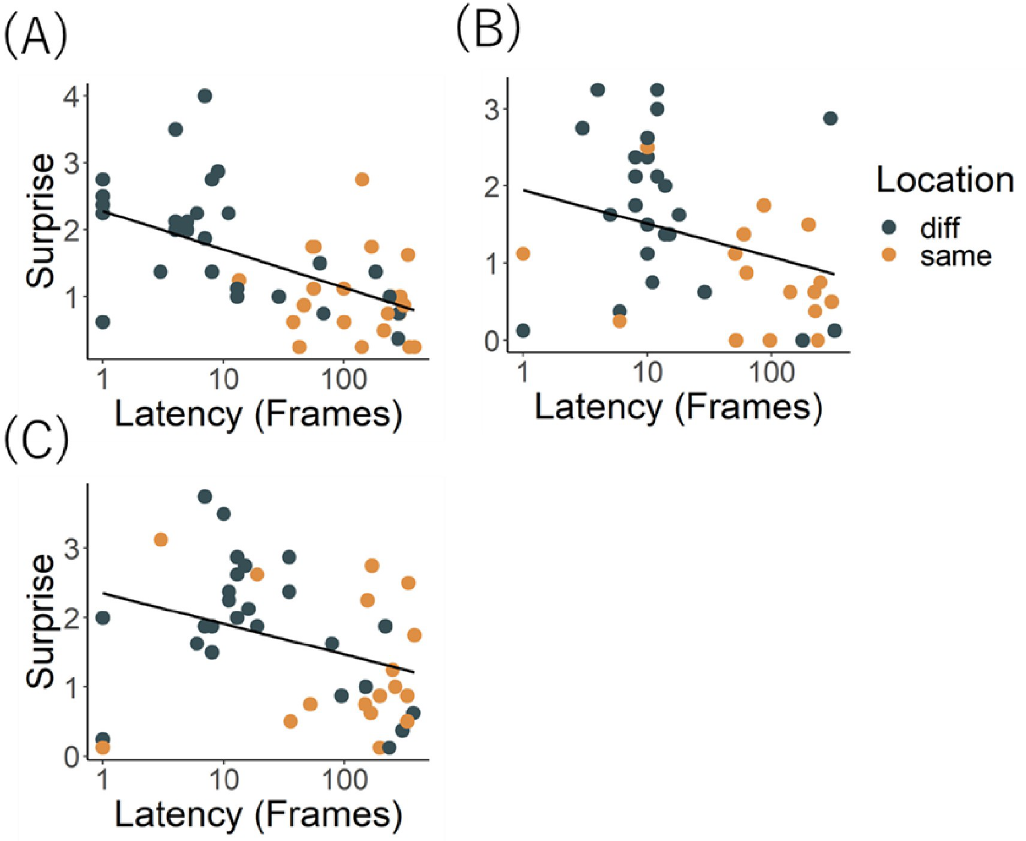
Fig 6. Correlation between latency to look back at speaker 2 and the magnitude of “surprise” as rated in (A) Exp.1, (B) Exp.2 and (C) Exp.3. Orange point represents Same location , blue black points represent Diff location, regardless of Sound condition.